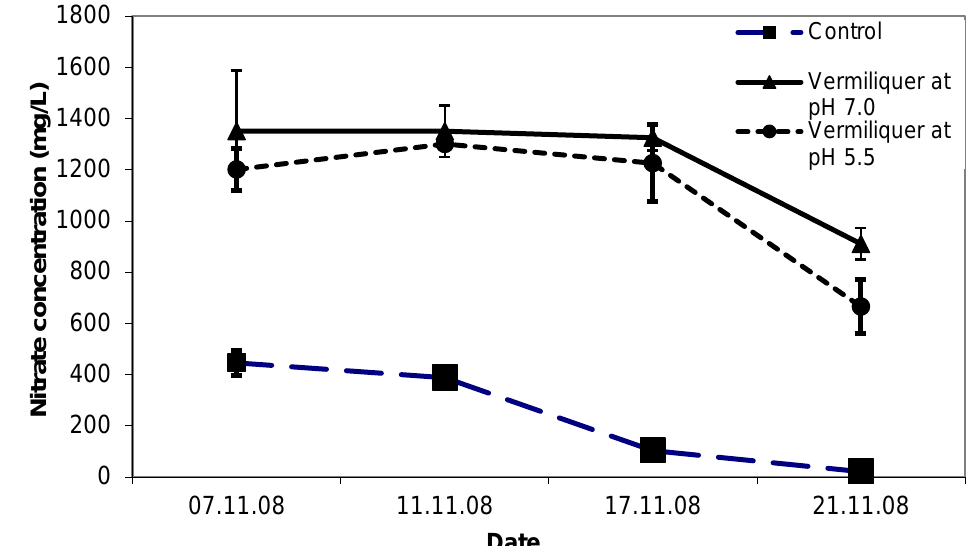
Figure 1. Quantity and timing of pH buffer (10% HNO 3 ) used in Study II to achieve different pH of vermiliquer nutrient solution, transplanted 31 October 2008.